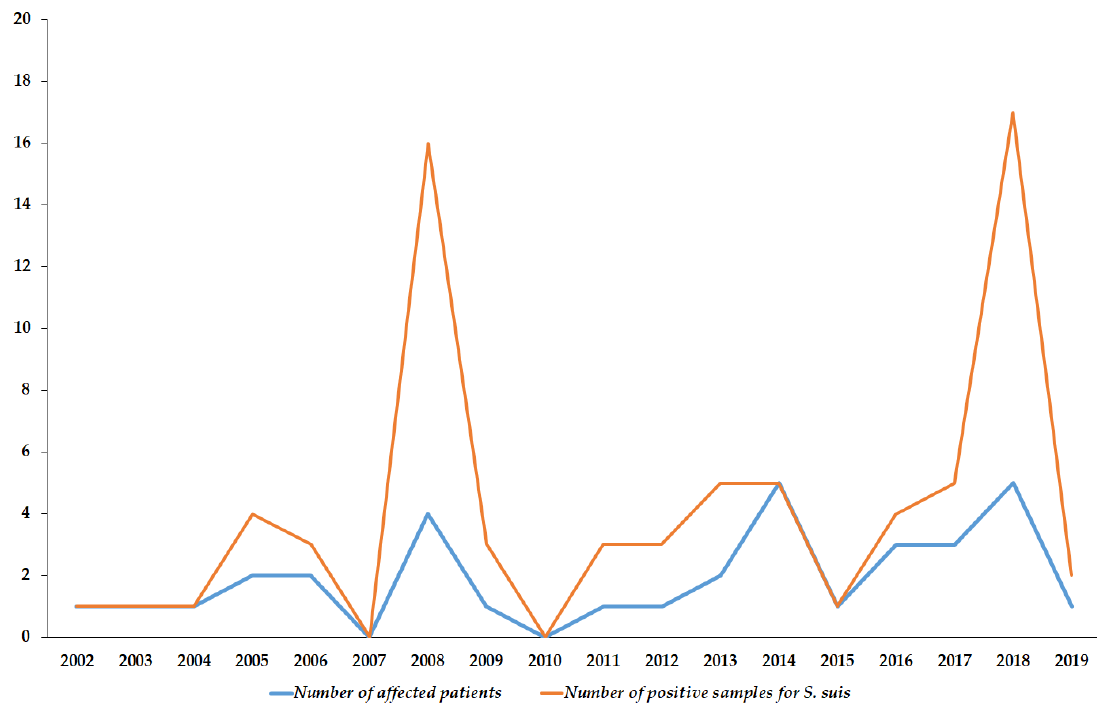
Figure 1. Secular trends of the isolation of S. suis in Hungary (2002–2019).